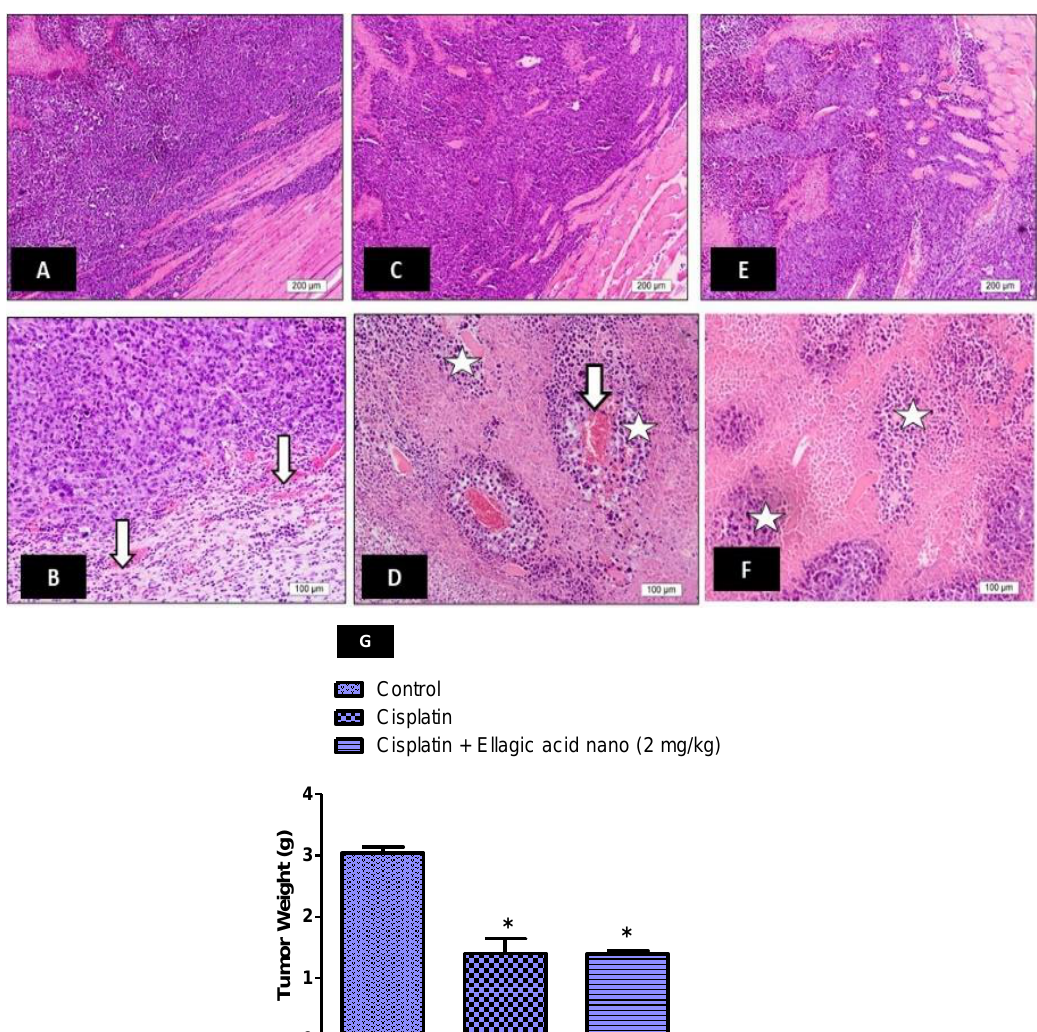
Figure 6. Impact of ellagic acid nanoformulation on solid Ehrlich carcinoma histopathology examined in cisplatin- (3.5 mg / kg) treated rats. ( A , B ) Control Ehrlich carcinoma: marked angiogenesis in non-treated solid Ehrlich carcinoma and active malignant cells with marked nuclear pleomorphism (star). ( C , D ) Cisplatin: absence of angiogenesis at the tumor periphery (black star) with few blood vessels at the central region (white arrows); notice the degenerated tumor cells with dark pyknotic nuclei (white star). ( E , F ) Cisplatin + Ellagic acid nano (2 mg / kg): absence of angiogenesis with marked degenerative changes in tumor cells (white stars). ( G ) A bar chart showing tumor weight in all the experimental groups. Results were presented as mean ± SE (n = 6). * p ≤ 0.05 relative to the control Ehrlich carcinoma group.